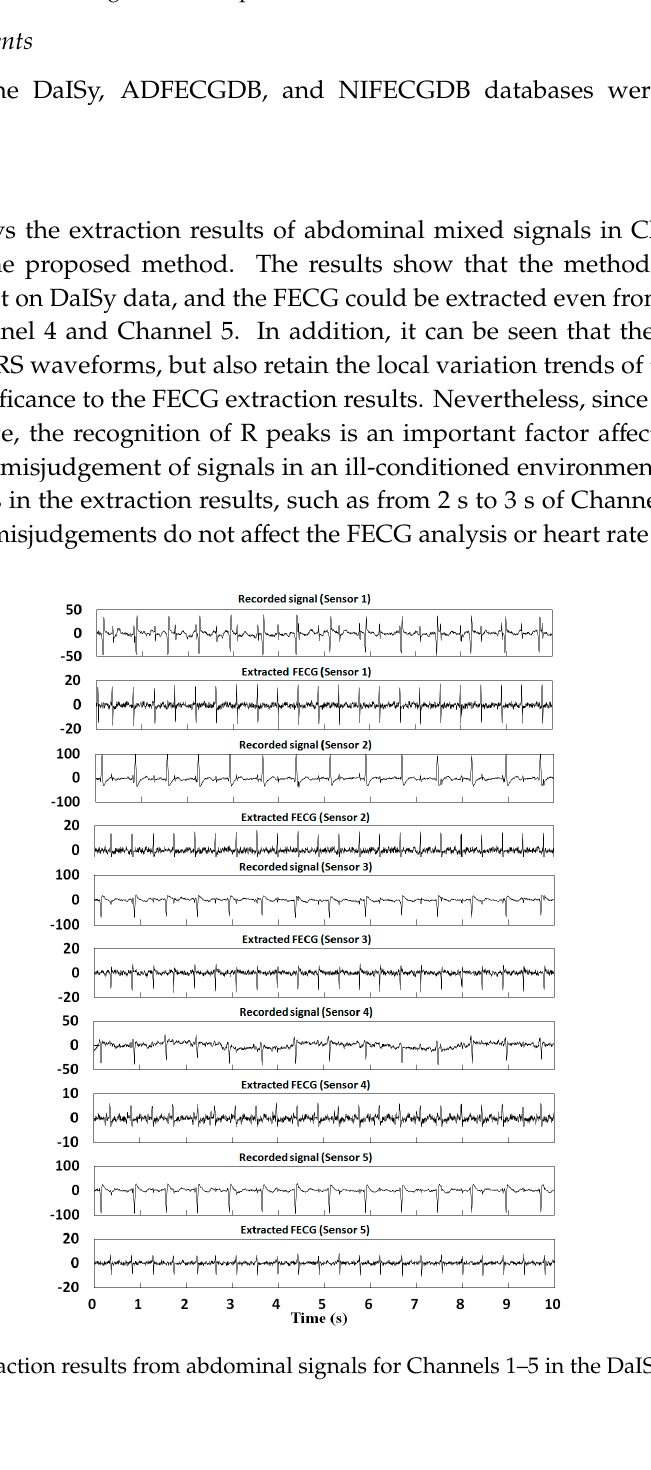
Figure 10. The change of SNR improvement with FMHRR when FMAR is fixed.